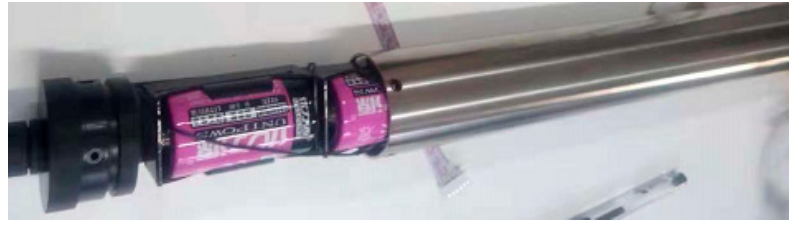
Figure 11. The 48 mm steel-pipe installation of an NB-IoT-based D/RTU, used by EMULSION.